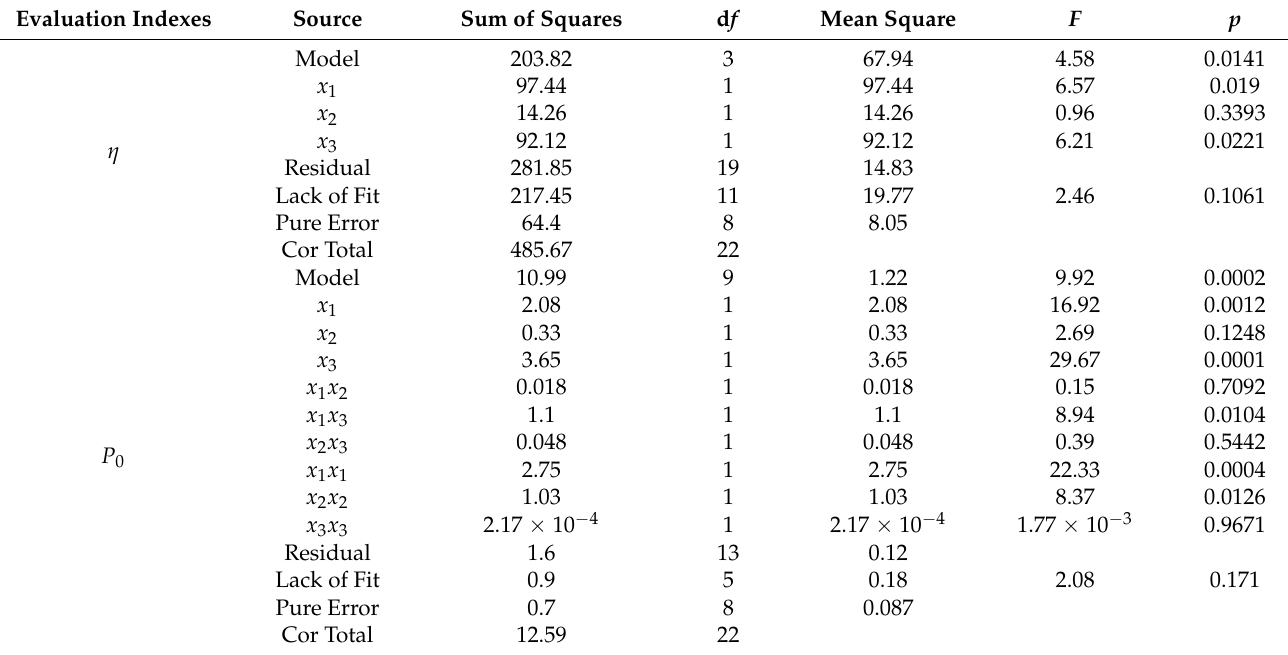
Table 3. Analysis of